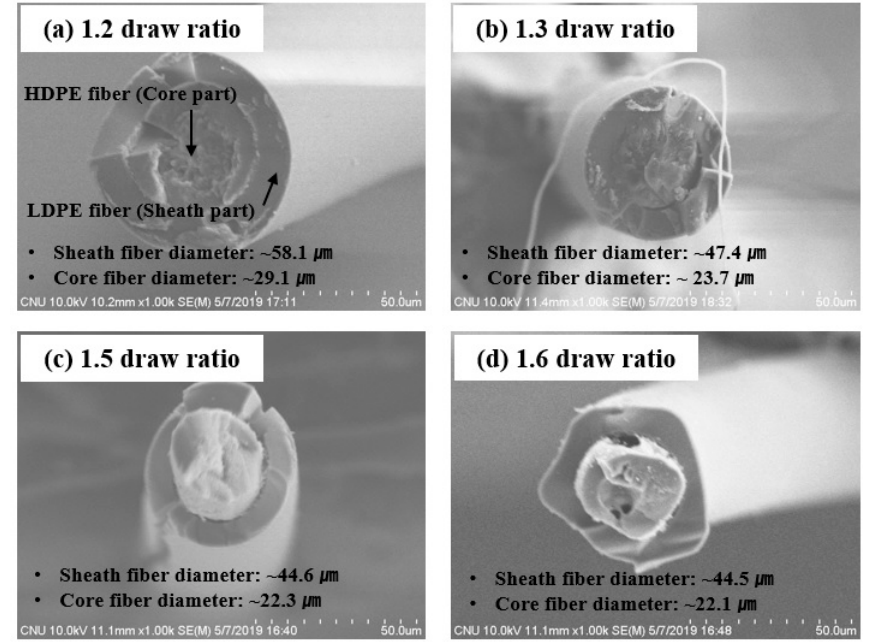
Figure 3. Cross-sectional SEM image of LDPE/HDPE sheath-core fibers manufactured at different draw ratio of 1.2–1.6 times.